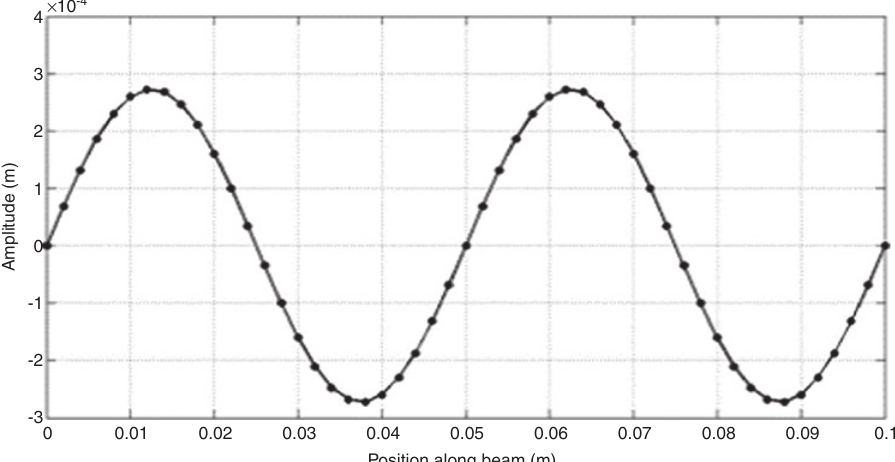
Figure 20: Vibrations of the fourth characteristic mode of the simply supported